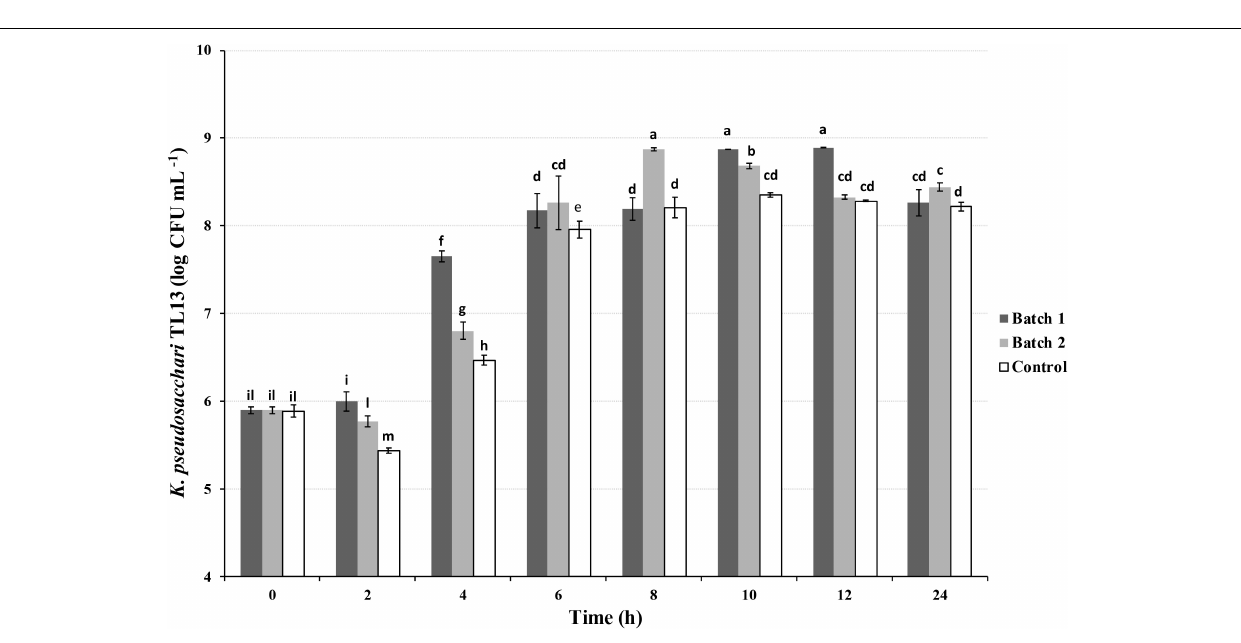
FIGURE 3 | Viable count of Kosakonia pseudosacchari TL13 during its growth in batch experiments using BHI medium (30 ◦ C and pH 7.00). Batch 1: shaking at 130 rpm; Batch 2: shaking at 130 rpm and air sparging at 0.5 vvm; Control: no shaking and no air sparging. The error bars represent the means ± SD of three replicates. Different letters indicate significant differences ( P <